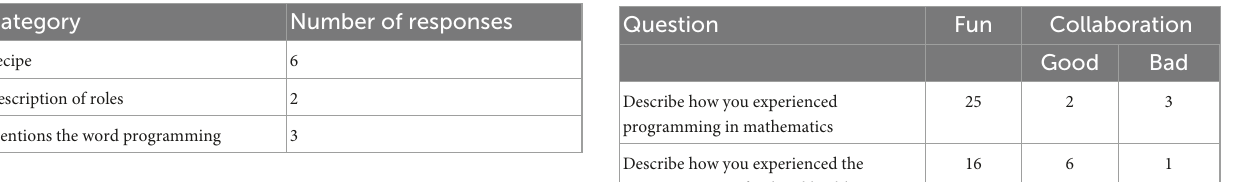
TABLE 1 Categories that can be connected to programming on the question: “Describe how you experienced the programming in food and health”.